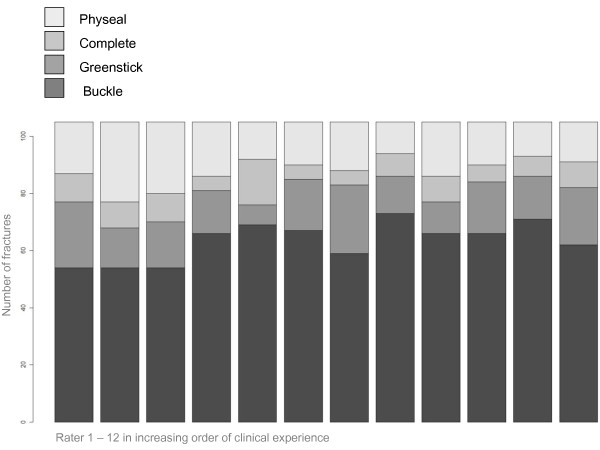
Classification of 105 consecuitive pediatric distal radius fractures into four categories by 12 raters in increasing order of clinical experience.